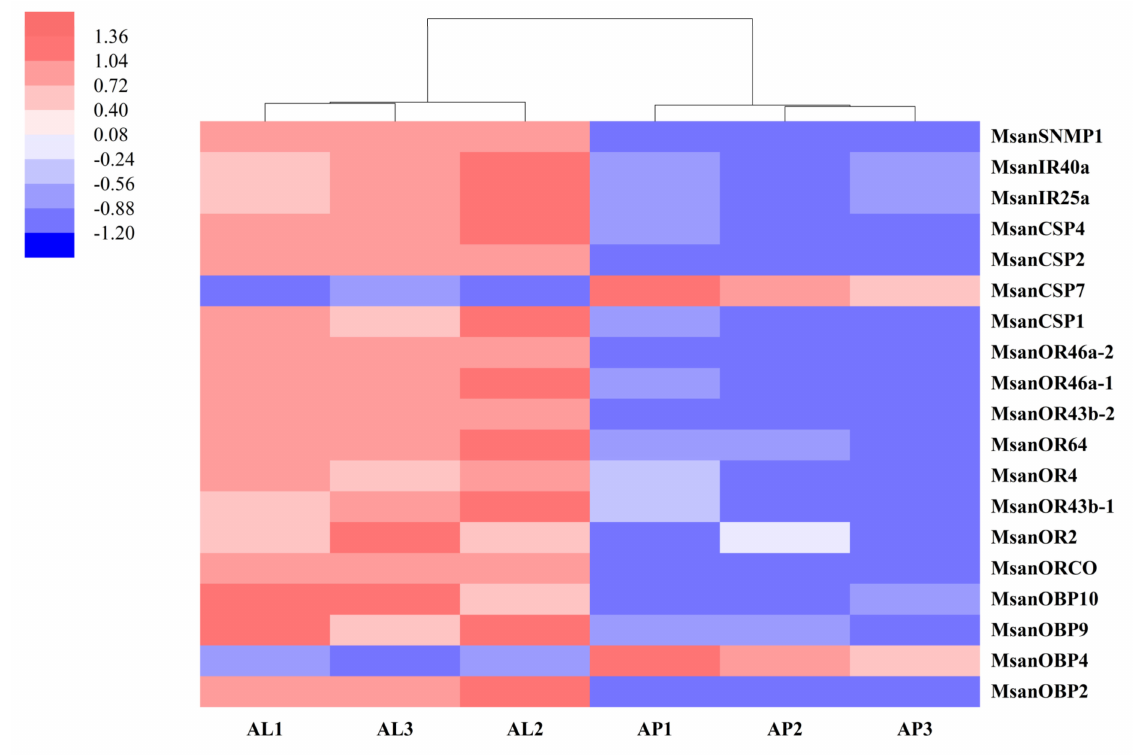
Figure 8. Expression profiles of chemosensory genes in antennal transcriptome of alate (AL) and apterous (AP) M. sanborni